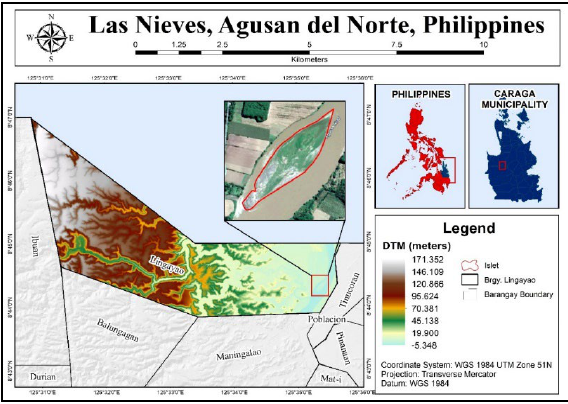
Figure 2 . (a) DJI D-RTK 2 Mobile Station attached to a Figure 1 . The Map of the Study Area, shown using the Updated surveyor’s tripod; (b) remote controller; (c) DJI Phantom 4 DTM of Las Nieves RTK and accessories in a box. Table 1 . Coordinates of the Static Survey known stations Table 2 . Summary of Agisoft Metashape Processing